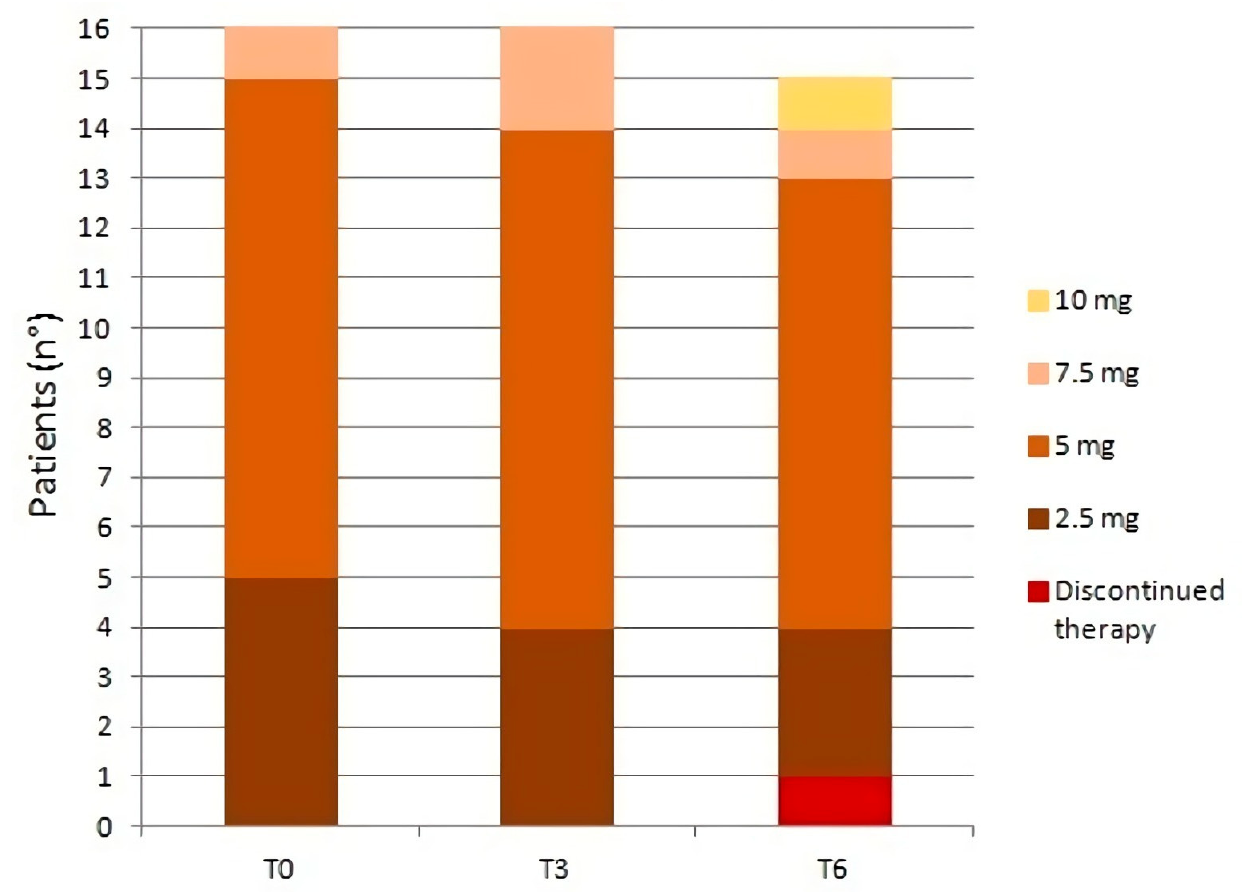
Figure 1. Changes in etelcalcetide dosage (mg/session) at T0, T3, and